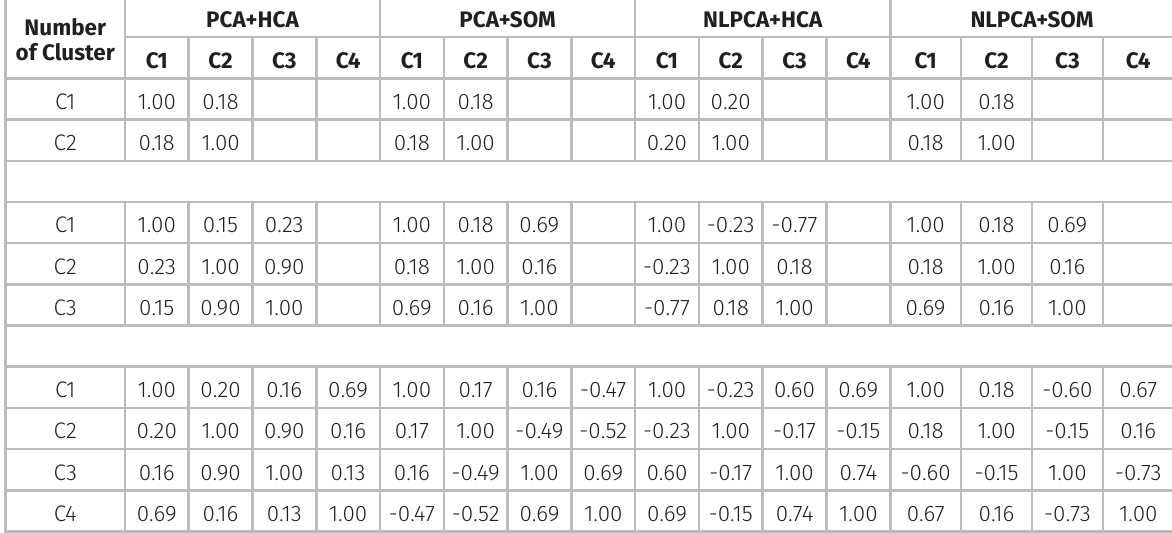
Table II Correlation coefficients between each region Number of